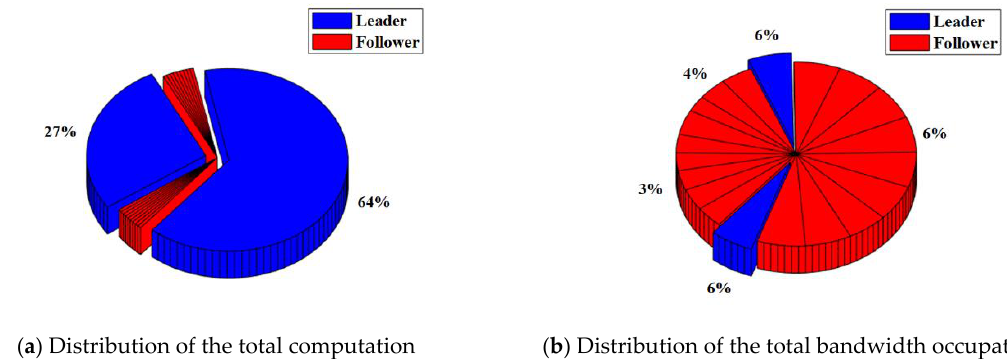
Figure 16. Resource occupation of the DDPOS algorithm with no malicious nodes.